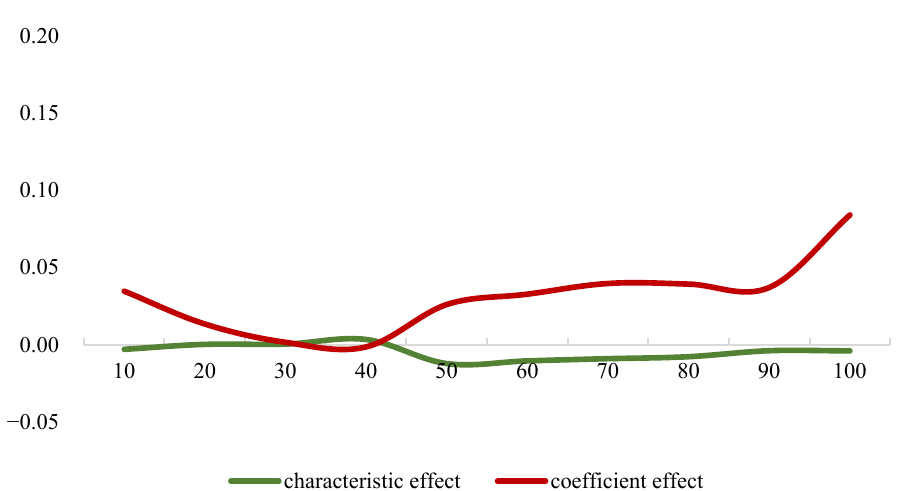
Figure 2. Variation in characteristic and coefficient effects.